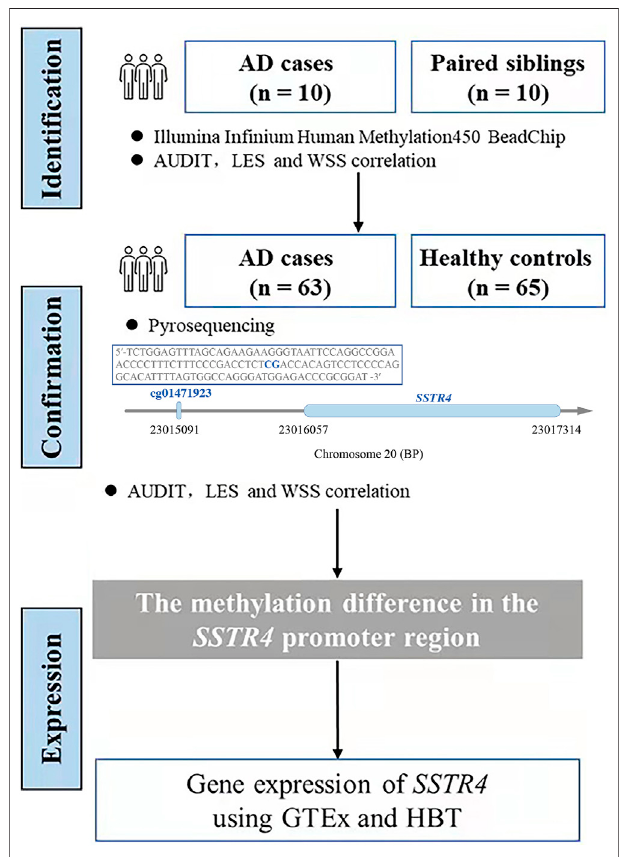
FIGURE1| The fl owchartofresearch.Weusedthesequenceinthebox by pyrosequencing to examine the methylation level of cg01471923 (chr20: 23015091), a CpG site located at the promoter region of gene